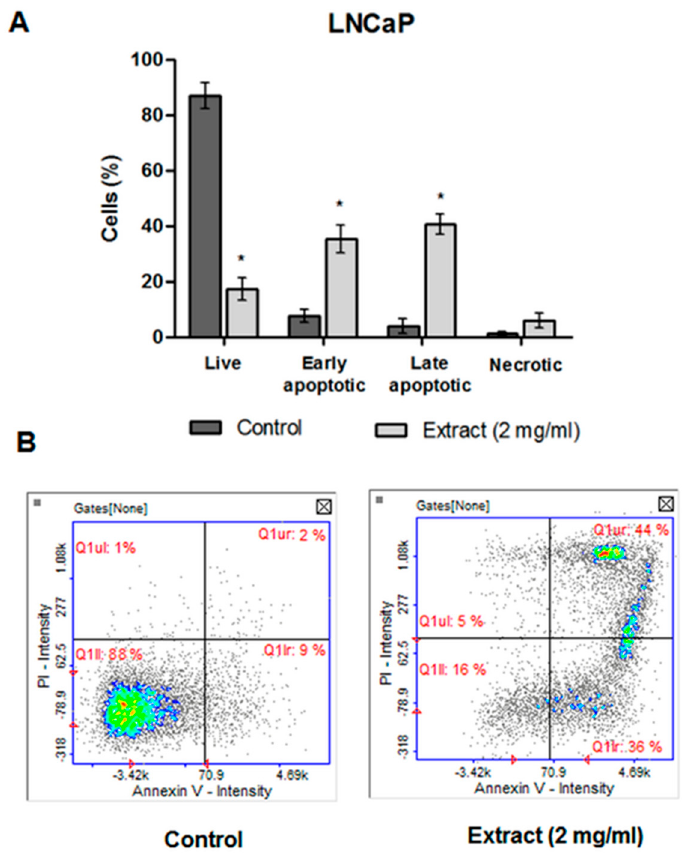
Figure 7. ( A ) Detection of cell apoptosis in LNCaP cells by image cytometry (Annexin V-FITC and propidium iodide staining). The LNCaP cells were treated with 2 mg/mL of CA extract or DMSO as a vehicle in control cultures for 48 h. Data were presented as mean ± SD obtained from three independent experiments. * p < 0.05 vs. control. ( B ) Representative histograms (Q1II—live, Q1Ir—early apoptotic, Q1ur—late apoptotic, and Q1uI—necrotic cells).